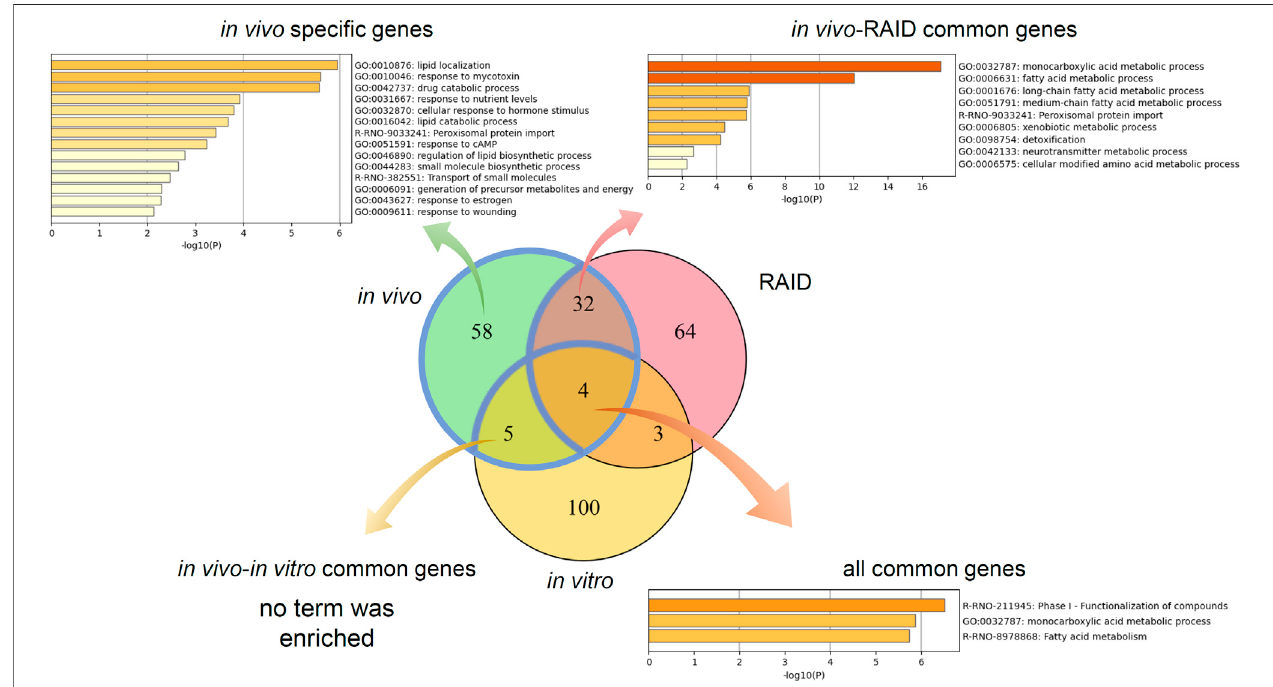
FIGURE4| Commonalitiesofprincipalcomponent – relatedgenesandtheirbiologicalfunctionsanalyzedbygeneontologyandpathwayanalyses.Venndiagramof genes related to the fi rst and second principal components of in vivo , a virtual microarray (RAID), and in vitro data.